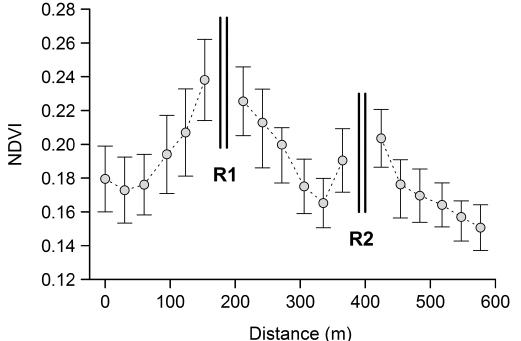
Figure 4. Relationship between NDVI and timing of low tide across the mudflat area. Satellite (SPOT and Landsat) data mean ND- VIs are represented according to their acquisition time relative to low tide (time = 0). Black symbols correspond to data character- ized by a decrease of biomass due to the process of vertical migra- tion and/or partial mudflat submersion (dotted polynomial regres- sion line, p < 0 . 001). After removing them, the regression was no longer significant (grey symbols, full polynomial regression line, p = 0 . 30).